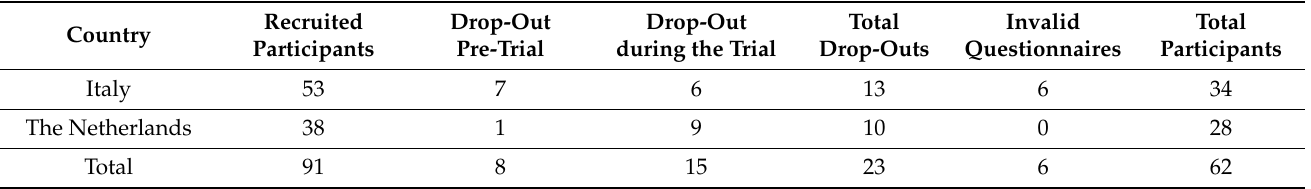
Table 1. Overview of participants per country.